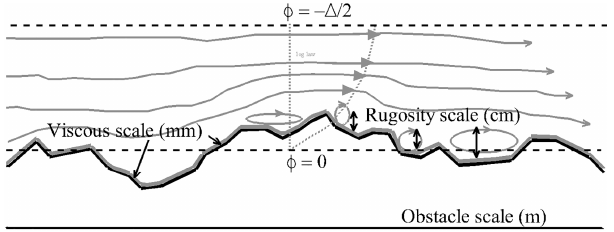
Figure 7. Illustration of the unresolved physical processes near a nonidealized solid wall (black line) in an atmospheric context: the length scale based on the viscous effects (grey line) is drastically smaller than the roughness length. The roughness length approaches the scale of smallest eddies and governs the log-law